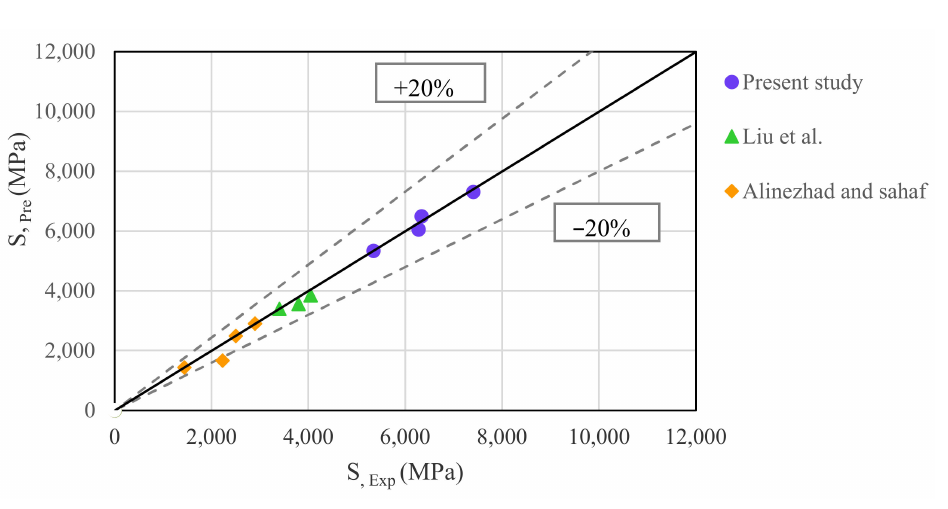
Figure 14. Comparison of the r flexural stiffness results between the proposed model and the laboratory results of other researchers.